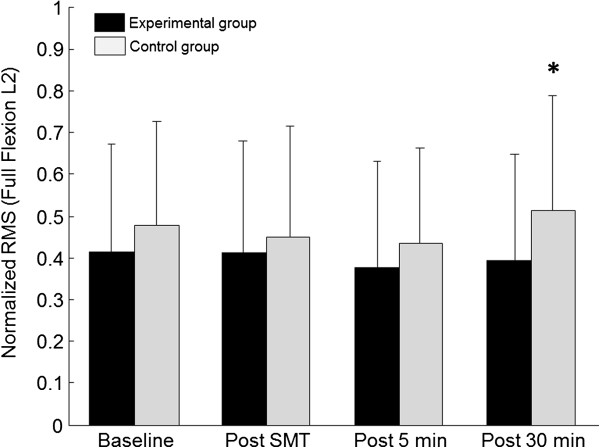
Mean baseline and post spinal manipulation L2 paraspinal normalized RMS values (EMG) for both the control and experimental groups during the full flexion phase of the task. *RMS values in the control group significantly increased during the last block of trials. Whiskers indicate standard deviation.